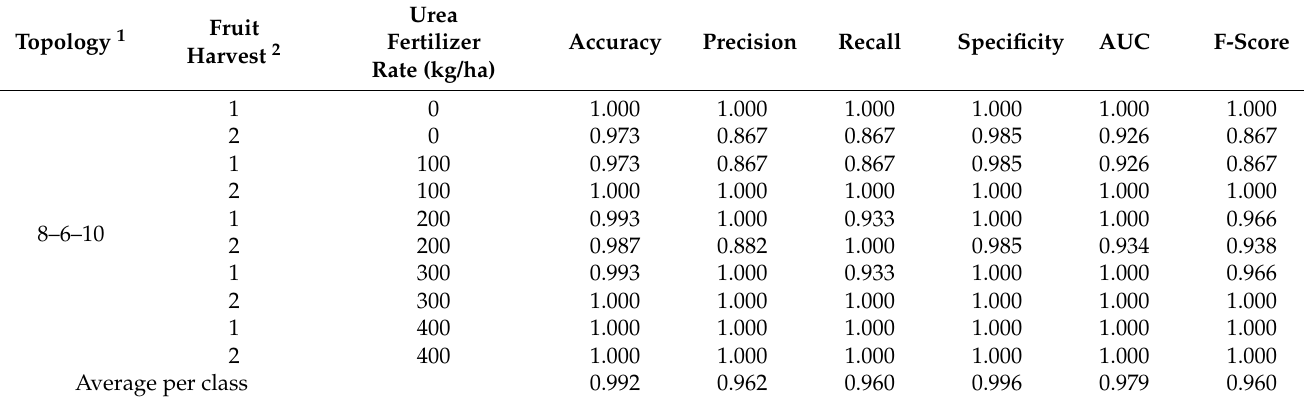
Table 8. Performance parameters of the ANN models for the 10-group classification.